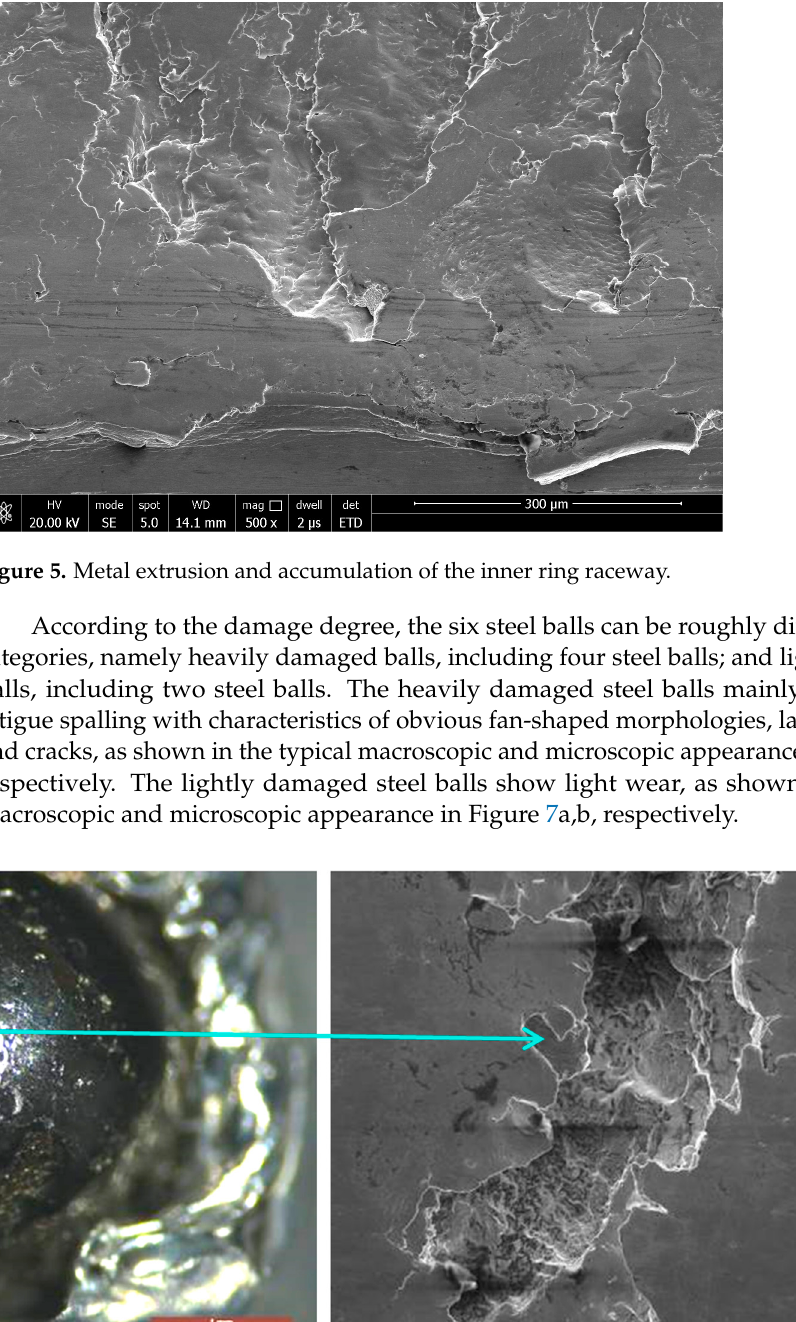
Figure 4. Contact fatigue spalling morphology of the inner ring raceway.